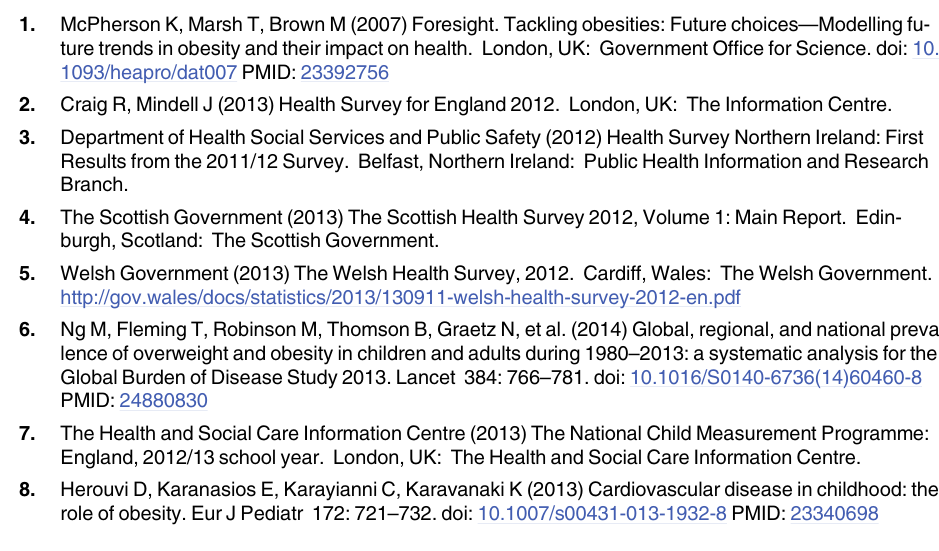
S6 Table. Percentages of adulthood BMI values above select centiles, estimated from sex- and study-stratified LMS models. S7 Table. Age scale and EDFs used in the fitting of sex-, study-, and life-course-stage — stratified LMS models applied to serial BMI data. S8 Table. Study-stratified, binary logistic, multilevel models in males to describe over- weight or obesity (versus normal weight) as a restricted cubic spline of age. S9 Table. Study-stratified, binary logistic, multilevel models in females to describe over- weight or obesity (versus normal weight) as a restricted cubic spline of age. S10 Table. Kruskal-Wallis tests of between-study differences in height, weight, and BMI Z-scores according to the UK-WHO chart at 10 or 11 years of age; diagonal values are medians (interquartile range), and off-diagonal values are Bonferroni-corrected p